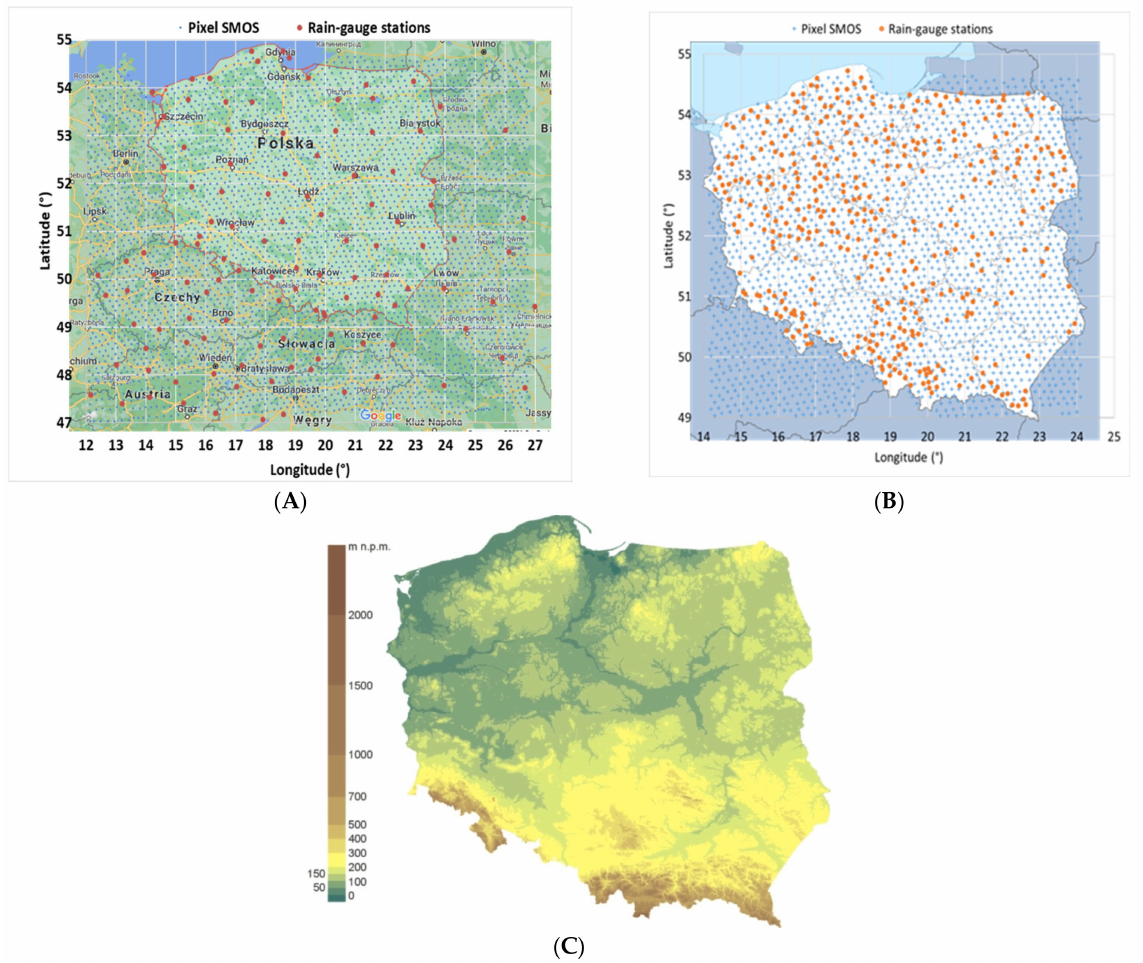
Figure 1. Spatial distribution of rain-gauge stations in Poland and neighbouring countries and SMOS pixel ( A ). Map was created using Google Earth (v. 7.3.2.5776). Google, proprietary software, https://www.google.com/earth/. The background maps from Google Maps (https://www.google.com/maps/@51.1367607,20.6545385,5.5z), accessed 12 April 2017, and https://pl.wikipedia.org/wiki/Plik:Poland_location_map_white.svg ( B ). Elevation map of Poland, n.p.m.—above sea level ( C ), https://pl.wikipedia.org/wiki/Mapa_hipsometryczna#/media/Plik:Poland-hipsometric_map.jpg. The background maps were modified using Microsoft Office PowerPoint